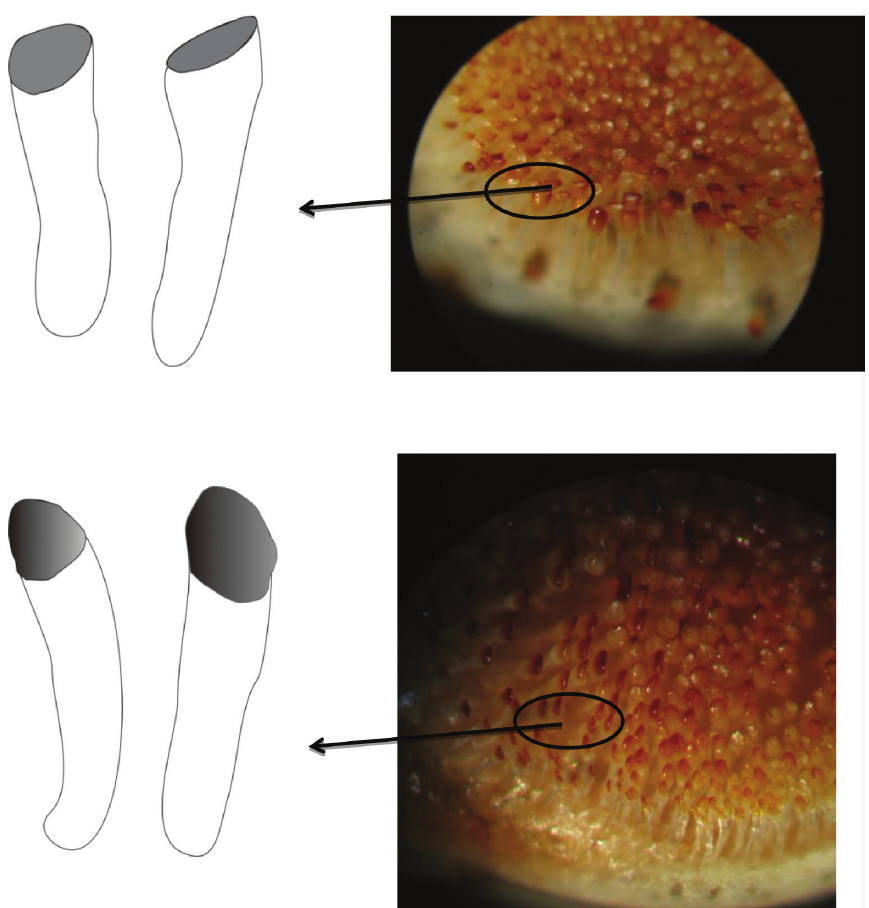
Figure 6. Lower and upper pharyngeal teeth of Iranocichla persa